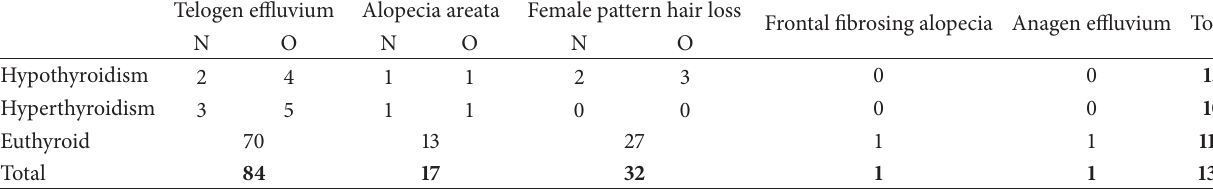
Table 3: Thyroid disorders throughout the spectrum of alopecia (new + old cases).